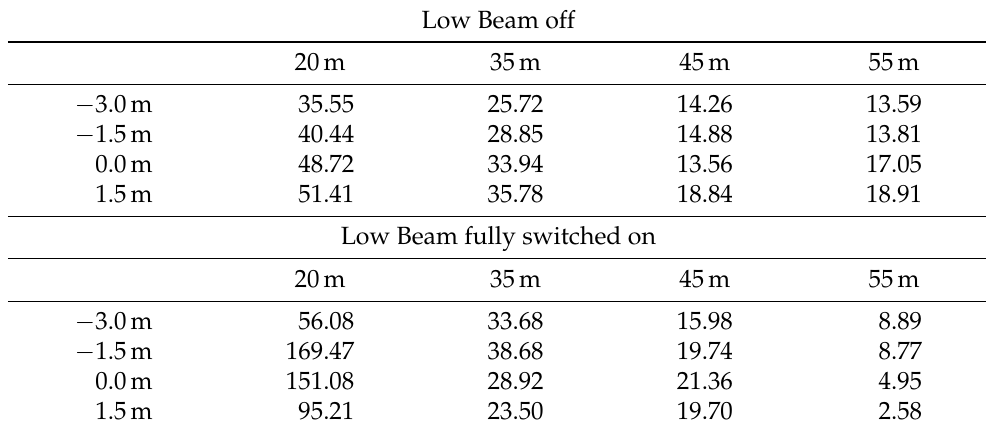
Table 7. Calculated Visibility Levels for test road 3, vehicle position